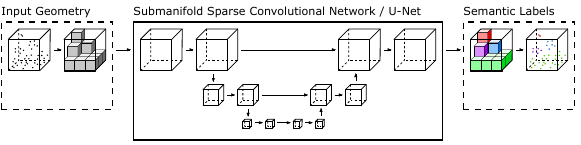
Figure 1. Diagram of the processing pipeline. A point cloud sam- ple is voxelized and then semantically segmented by an SSCN in the form of a U-Net. Afterwards, the voxel labels are transferred back to the original points. The spatial resolution of the sample is indicated as it passes through the network: the deeper the level, the lower the